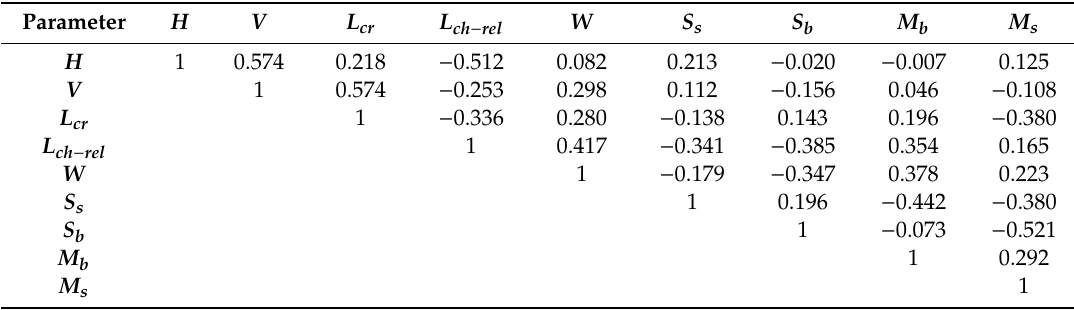
Table 7. Spearman rank correlation coe ffi cients calculated among model input parameters.